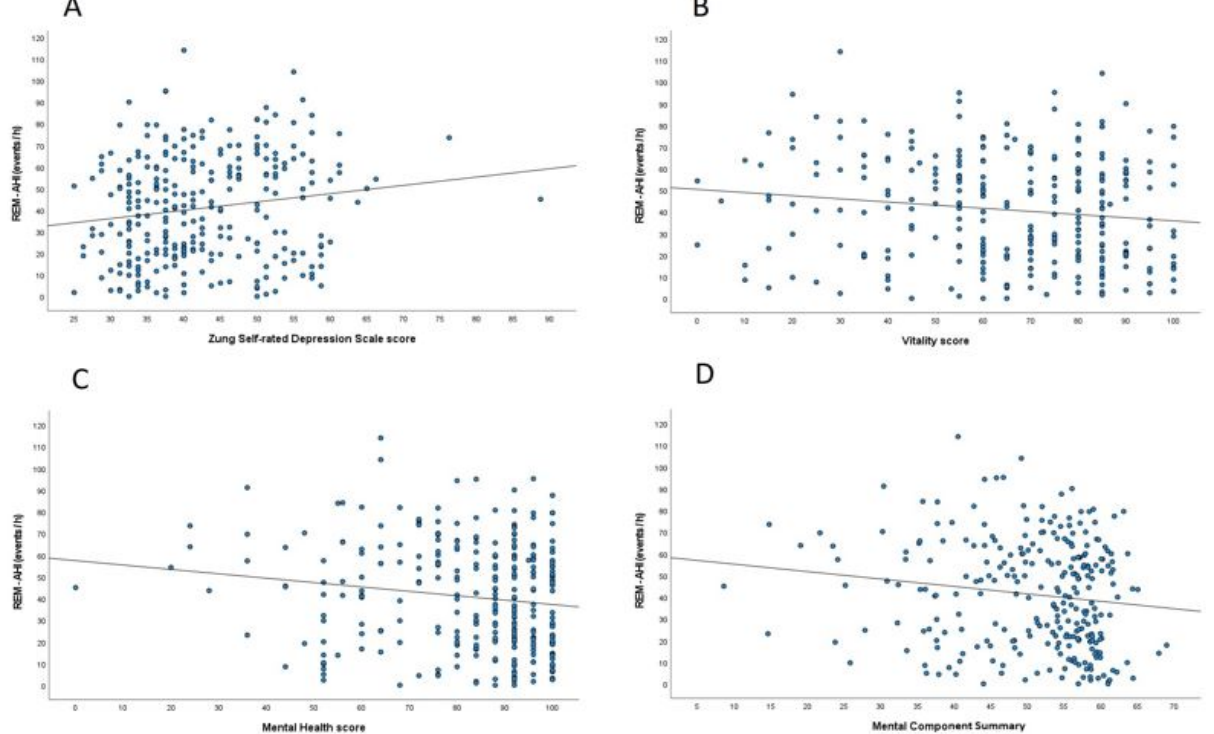
Figure 3. ( A ). Pearson analysis between REM-AHI and Zung Self-rated Depression Scale score. ( B ). Pearson analysis between REM-AHI and Vitality Score. ( C ). Pearson analysis between REM-AHI and Mental Health score. ( D ). Pearson analysis between REM-AHI and Mental Component Summary score. Definition of abbreviations : AHI = apnea-hypopnea-index; REM = rapid eye movements . Table 5. Variables associated with REM-AHI in adjusted linear regression analyzes.